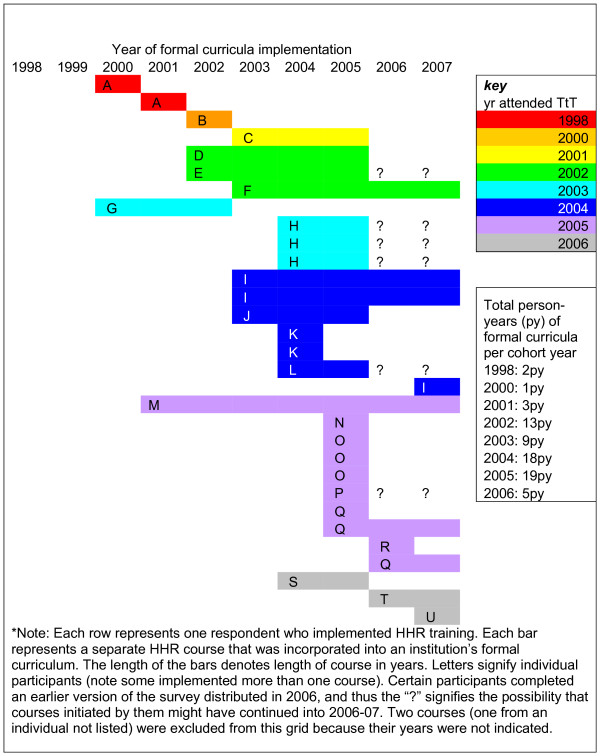
Timeline of formal curricula implementation*.